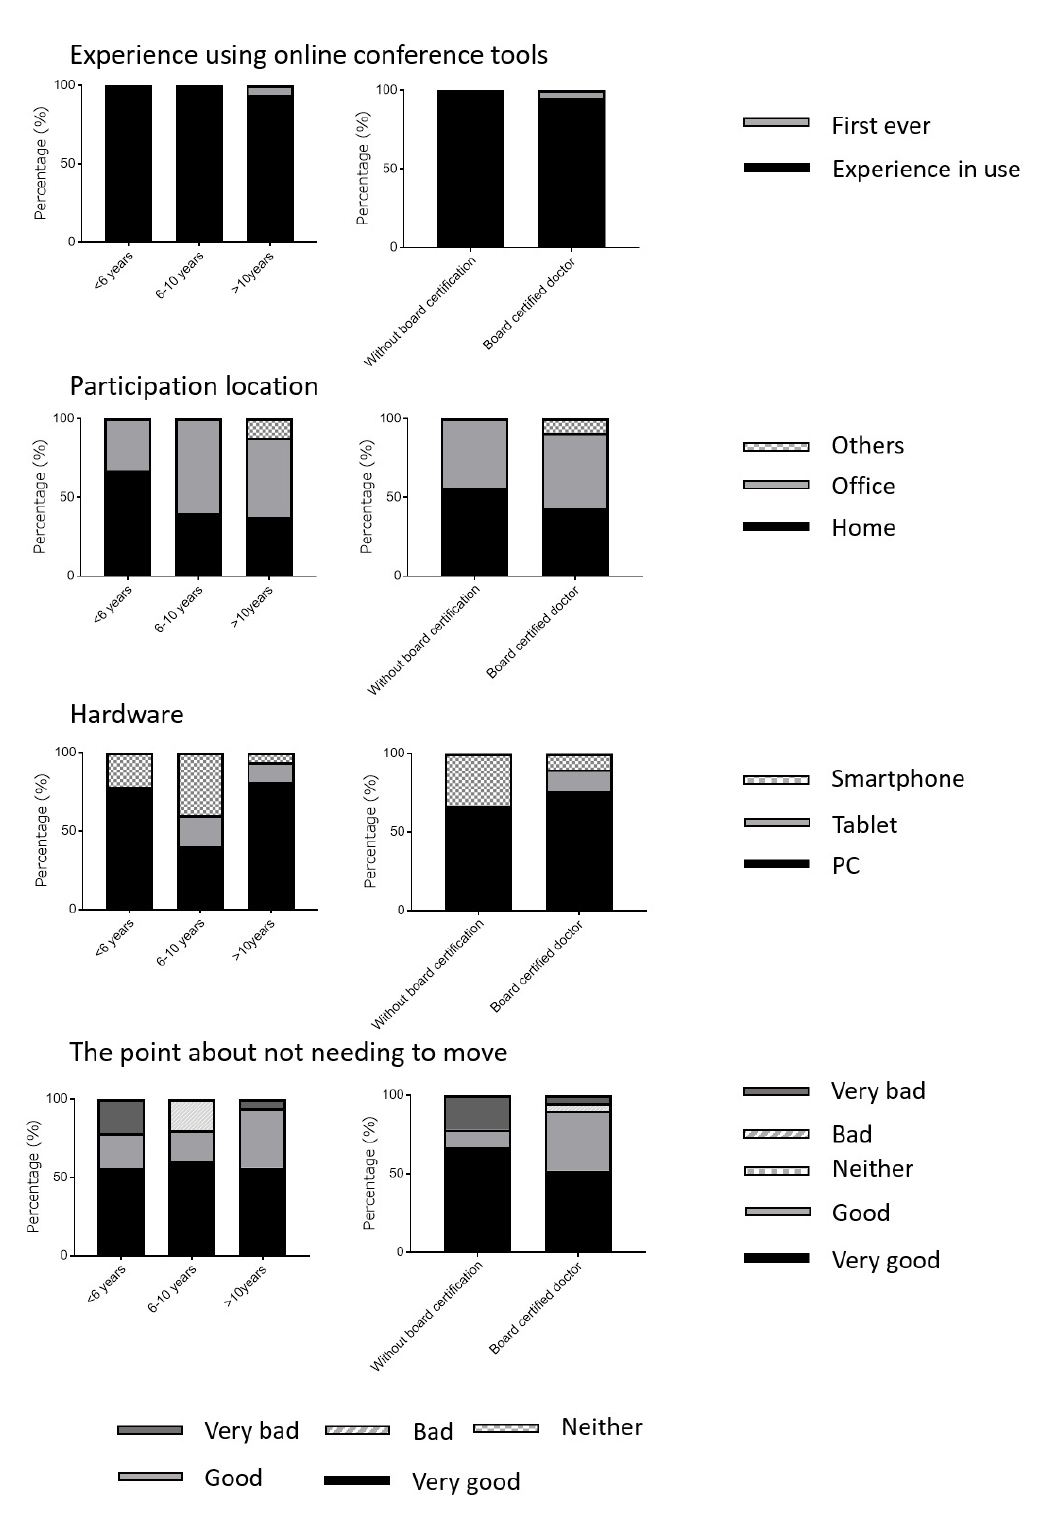
Supplemental Figure 1. Post-lecture questionnaire results based on medical specialty and years of experience. No significant differences were observed in terms of experience of using online tools, location, mobile equipment, or impressions regarding the meeting depending on years of oto- laryngology experience or being board